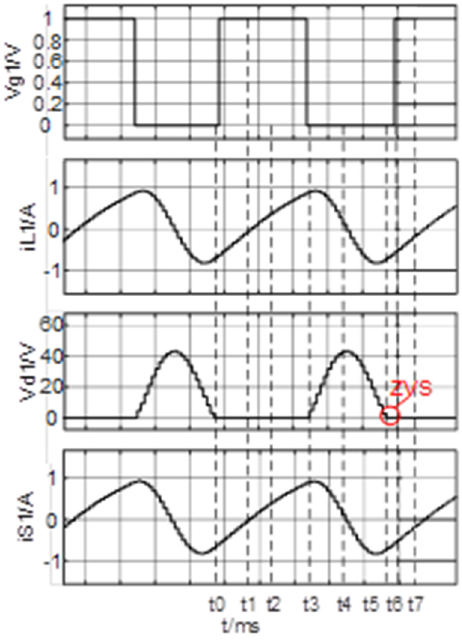
Figure 4. IDC transmitter modal waveforms.